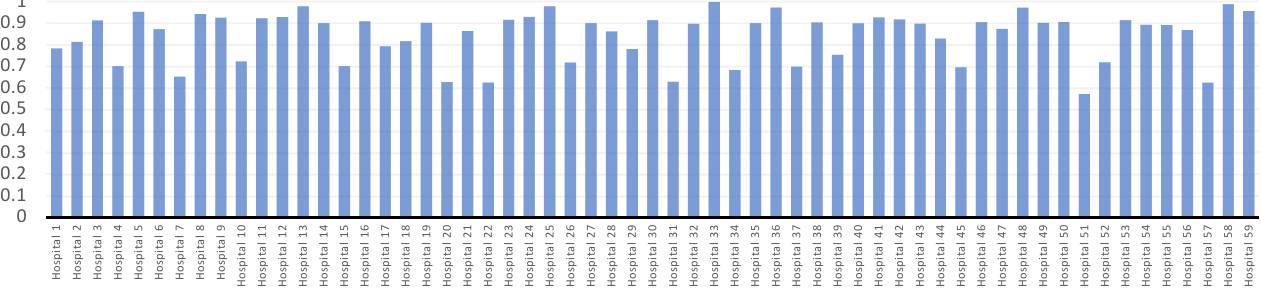
Figure 3. Hospitals’ technical efficiency results using SFA .